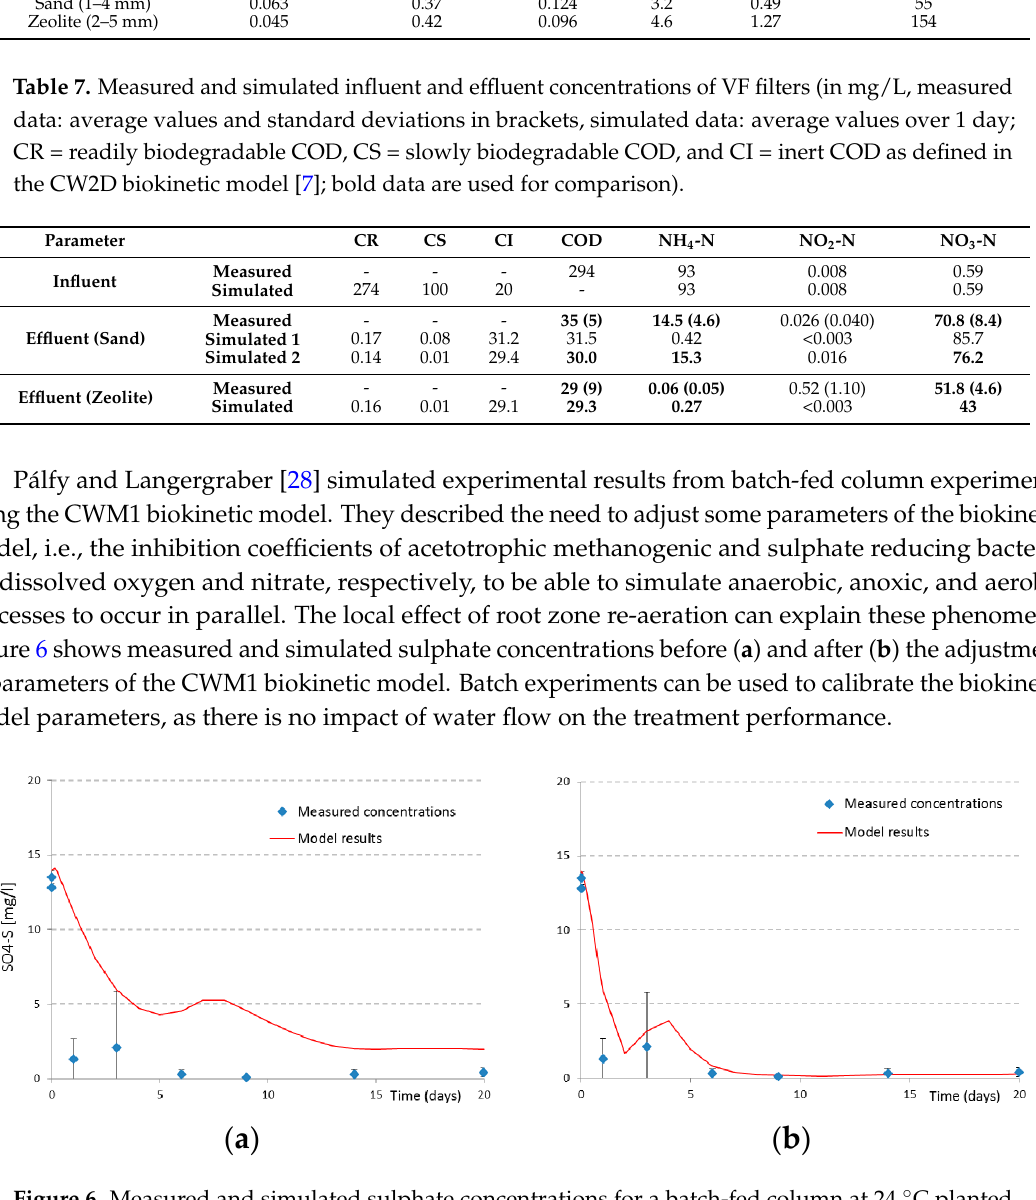
Figure 6. Measured and simulated sulphate concentrations for a batch ‐ fed column at 24 °C planted with Carex spp. (( a ): with a standard parameter set of the CWM1 biokinetic model; ( b ): after adjusting CWM1 biokinetic model parameters; adapted from [46]).